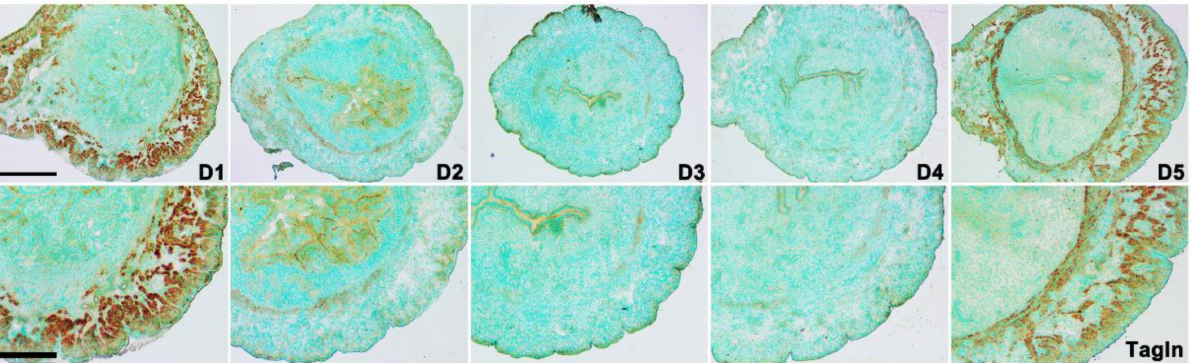
Figure 6. Expression of Tagln in mice uterus from days 1 to 5 of early pregnancy. In situ hybridization to detect the expression of Tagln in mice uterus on days 1 to 5 of pregnancy. Scale bars = 200 µ m, 500 µ